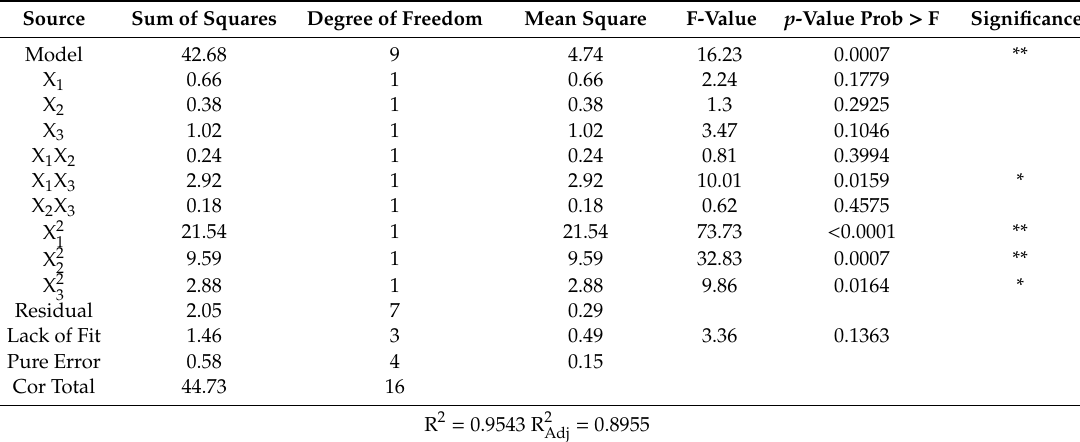
Table 3. Analysis of variance (ANOVA) of response surface quadratic